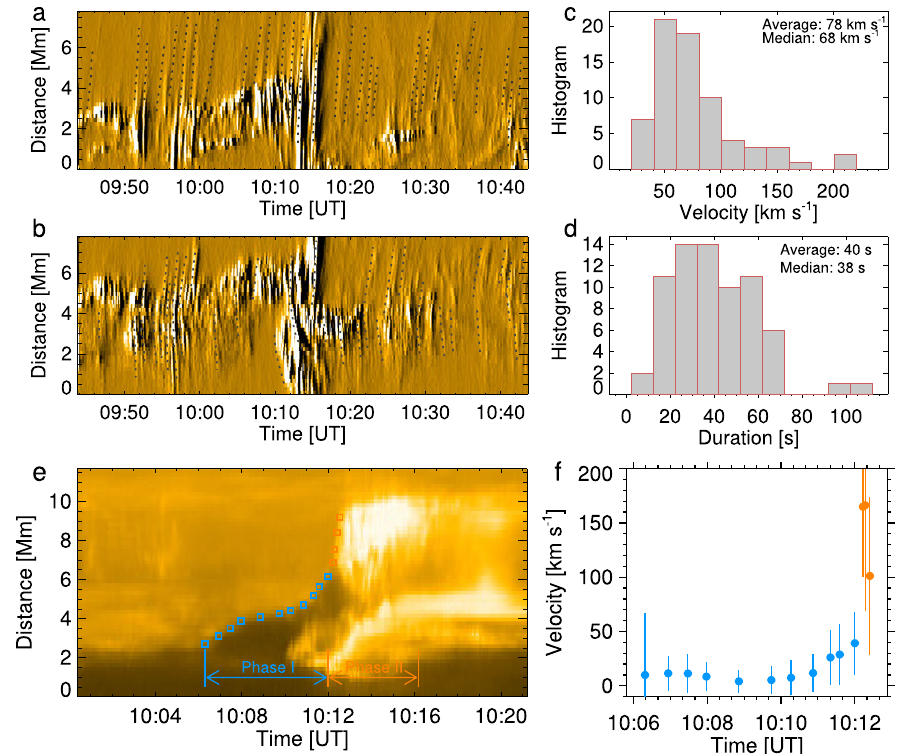
Fig.4|Dynamicsassociatedwithobservednull-pointreconnection.a Distance- timeplotoftheHRI EUV 174 Å running-differenceimagesshowingtheout fl owblobs along the spine indicated by the slit S1 in Fig. 2c. The velocities were calculated by linear fi tting ofthe height-time measurements as shown bydotted lines. b Sameas a but for the inclined slitS2 displaying the out fl ow blobs along the fan surface and the orientation slightly deviating from the outer spine. c , d Histograms of the blob velocity and lifetime, respectively. e Same as a but for the HRI EUV 174 Å original